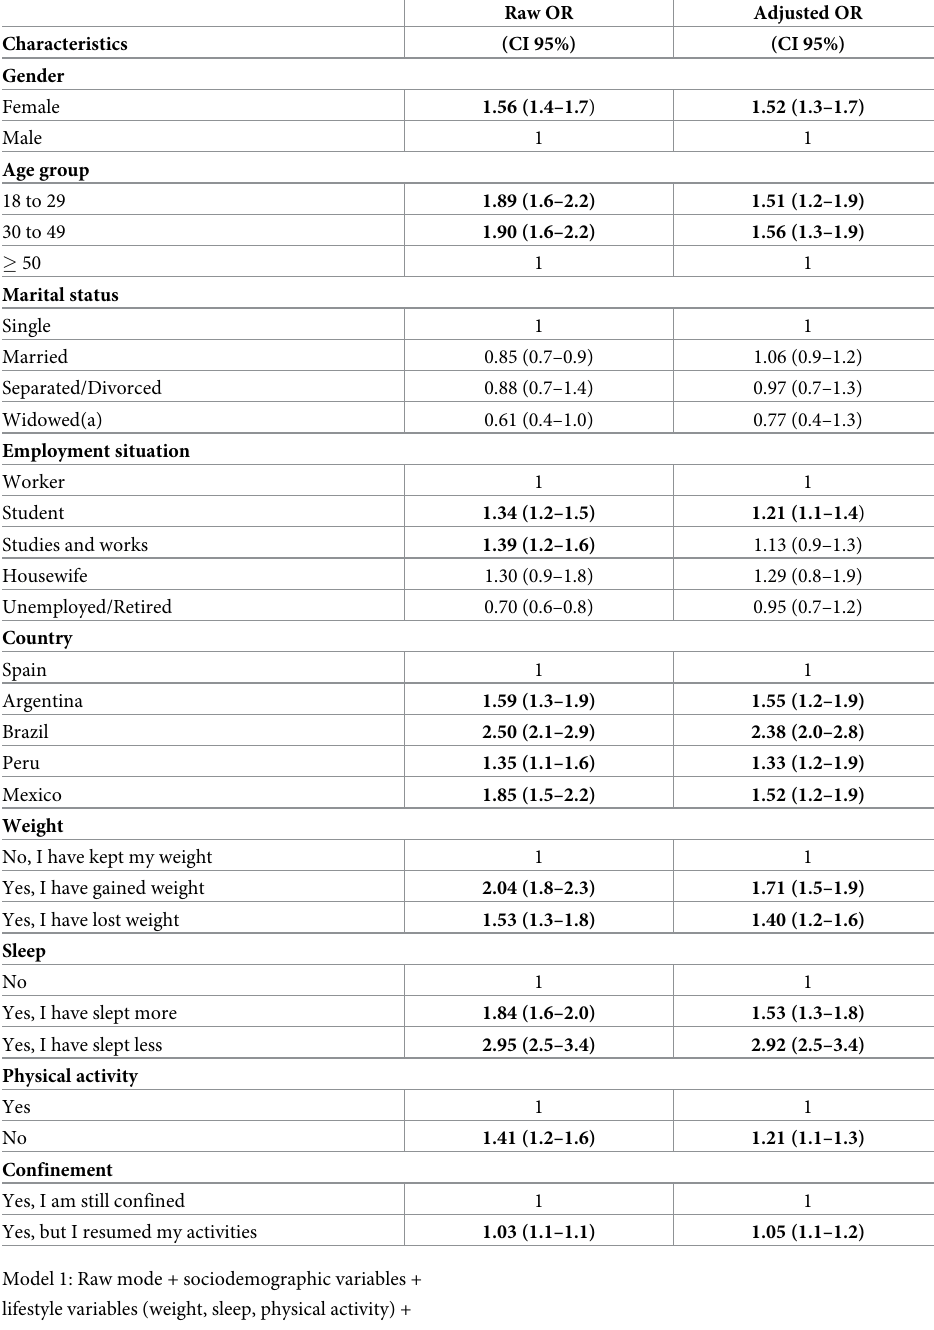
Table 2. Association of sociodemographic variables, lifestyle, and confinement among participants who have self- reported anxiety during the confinement due to the covid-19 pandemic in Argentina, Brazil. Peru, Me´xico and Spain 2020.